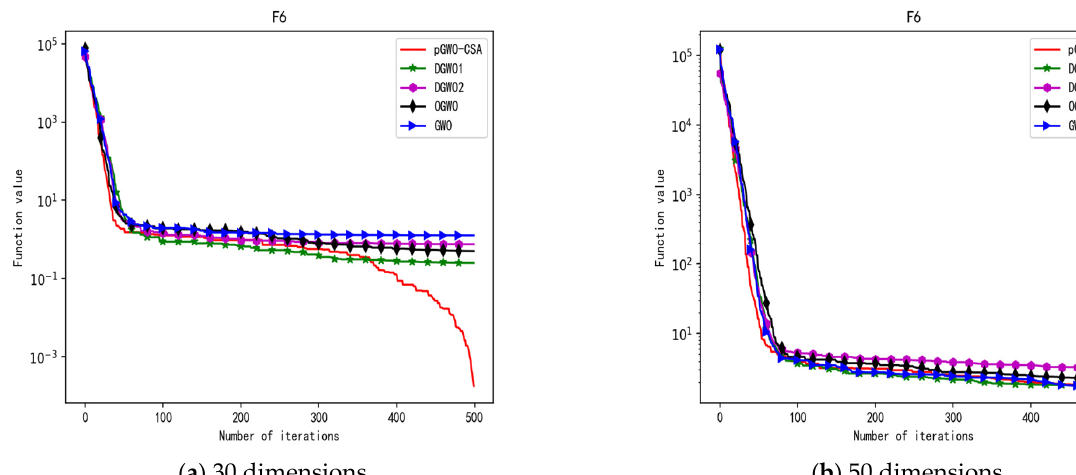
Figure 25. Convergence curve of test function F6.